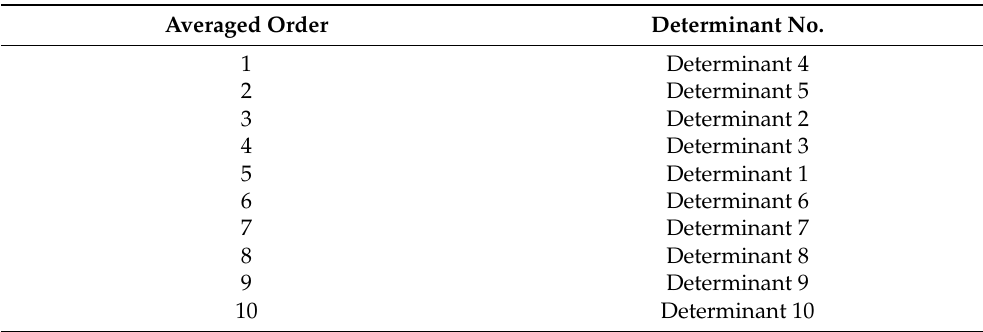
Table 2. Experts’ determinant